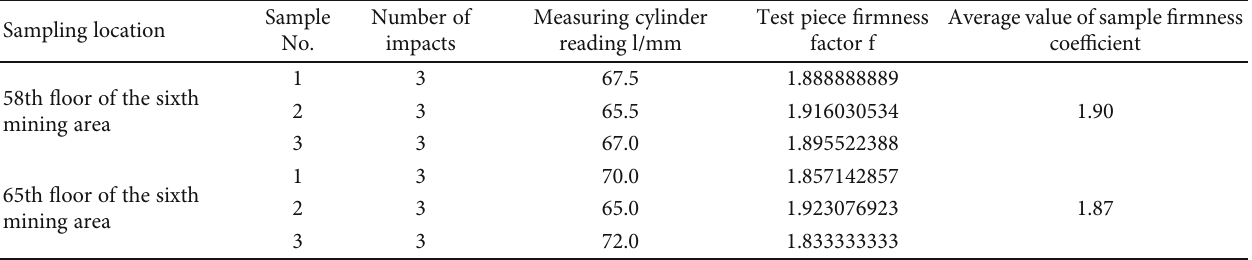
Table 3: Experimental results of coal sample fi rmness coe ffi cient.